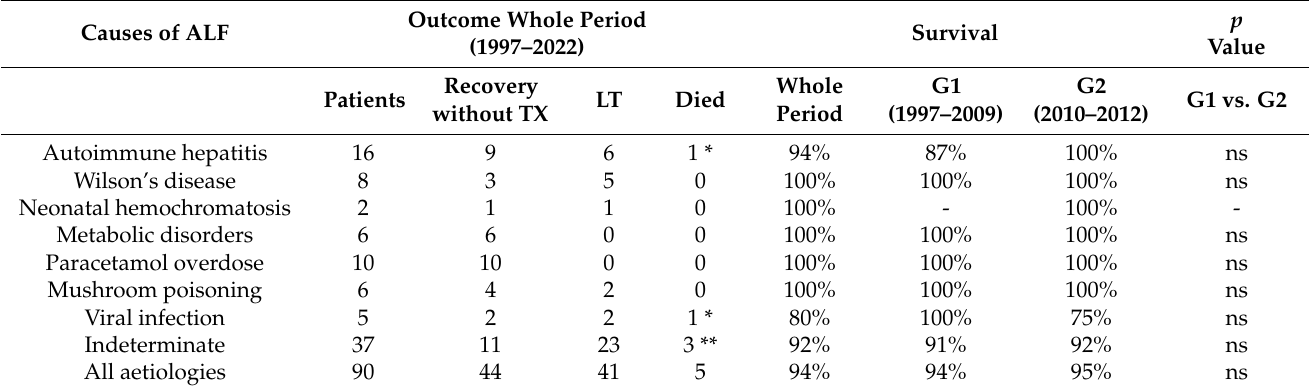
Table 3. Outcome according to aetiology in 90 patients with acute liver failure, whole period and comparison between two eras.